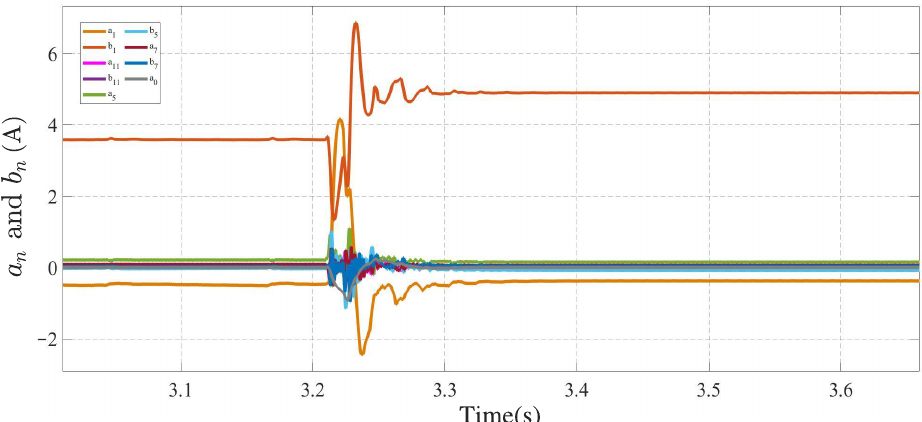
Figure 16. Experimental results: the values of each harmonic